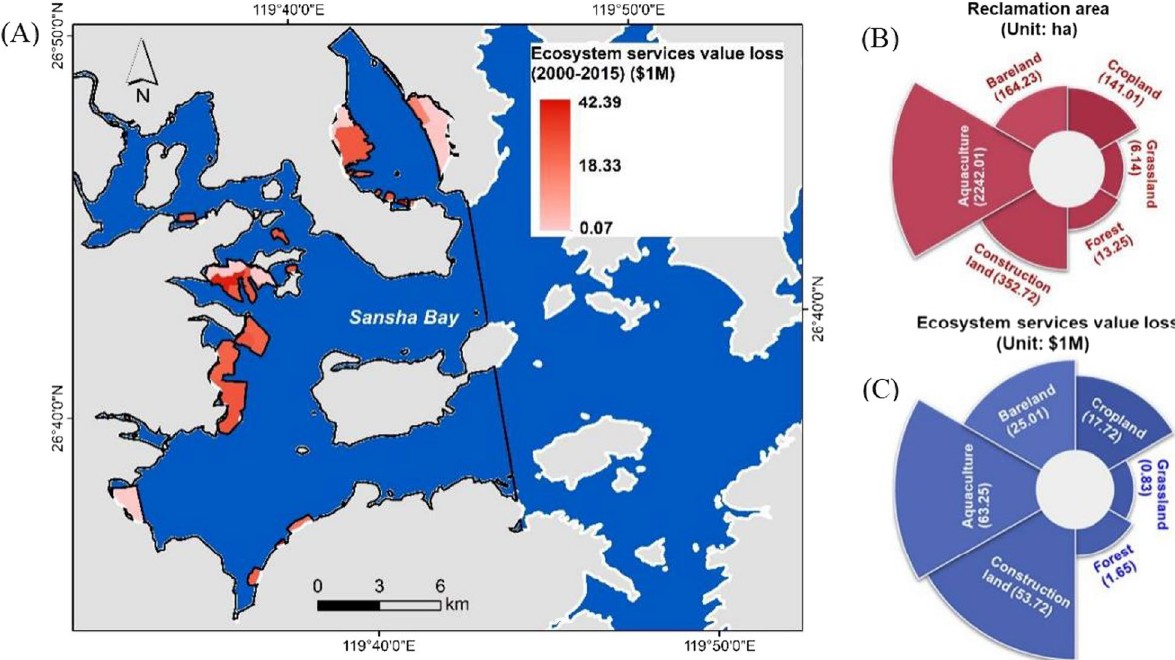
Fig. 3 A Ecosystem services value losses caused by reclamation in Sansha Bay from 2000 to 2015. B Types and area (ha) of different reclamation activities from 2000 to 2015. C Ecosystem services value loss caused by different reclamation